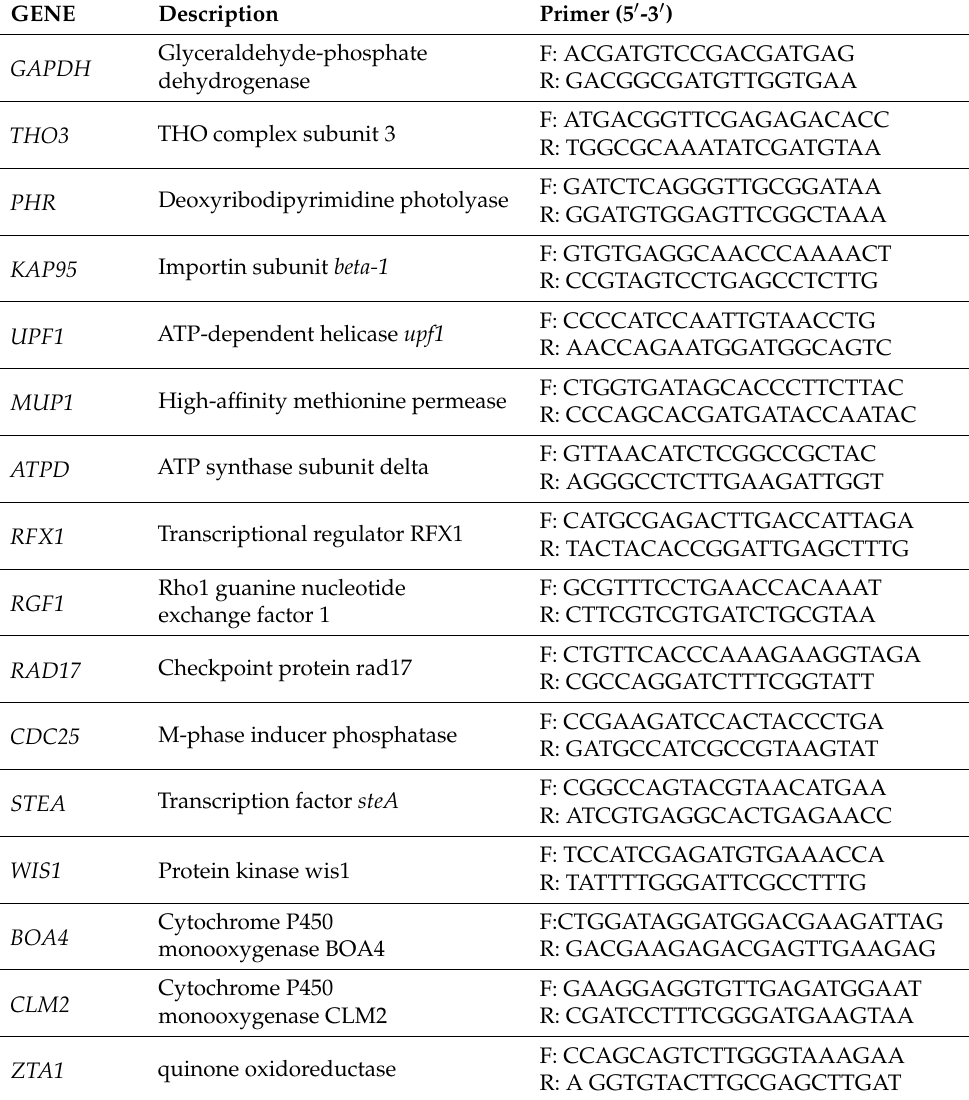
Table 3. Primers for